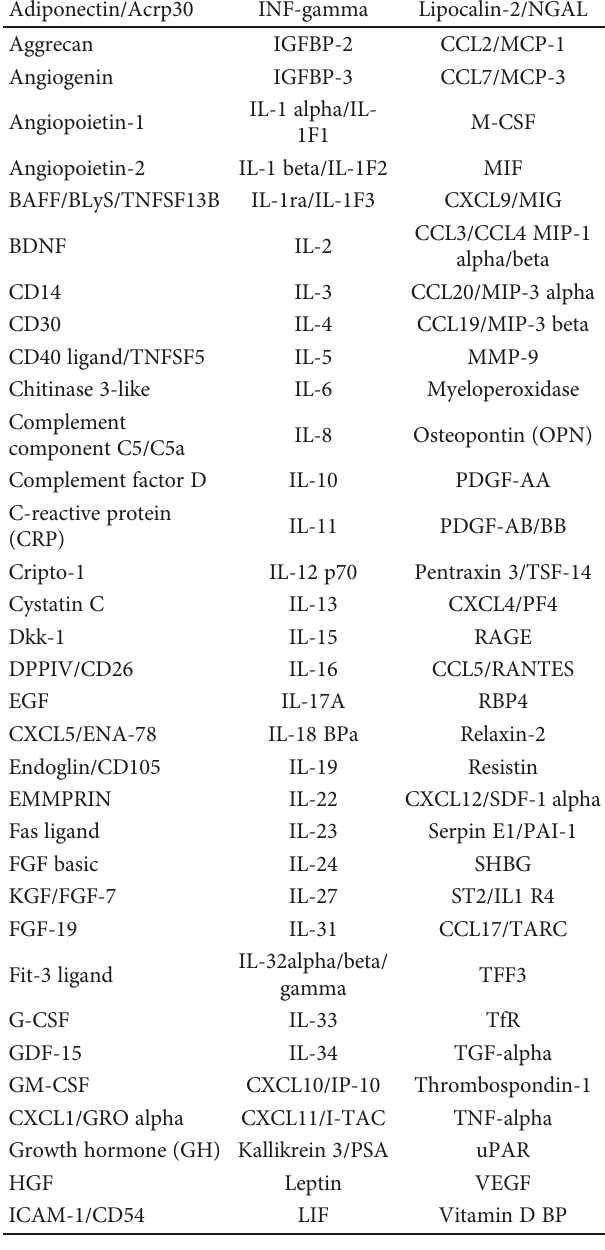
Table 3: Cytokine array